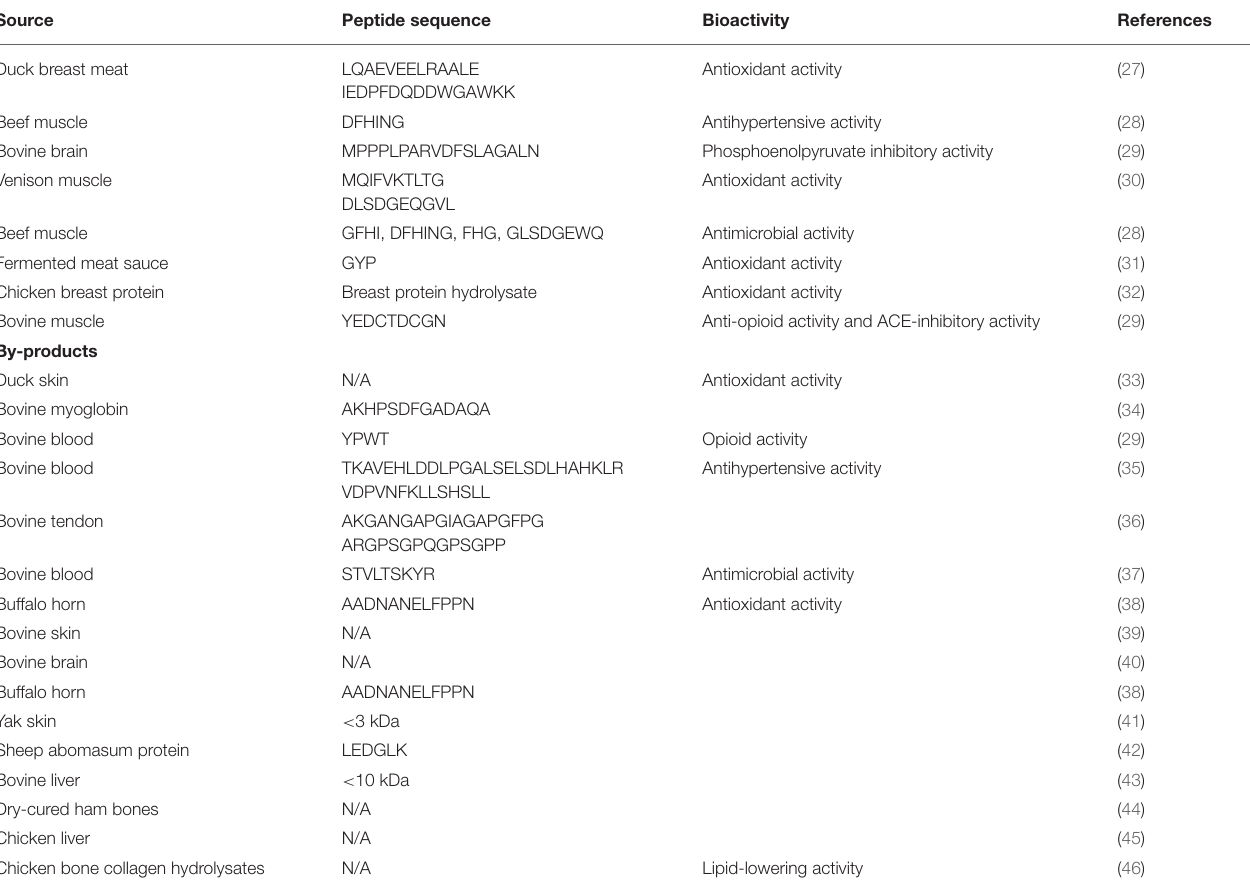
TABLE 2 | Peptides from meat and by-products and their